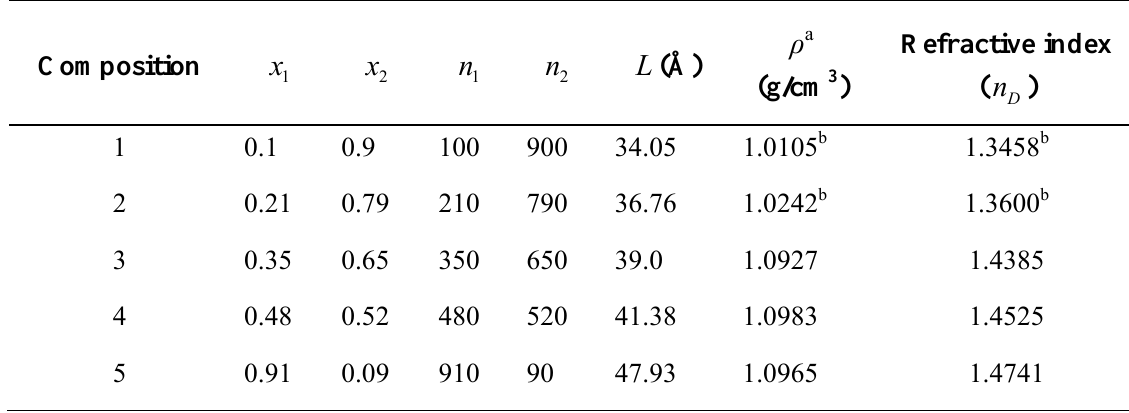
Table 2. Compositions of the DMSO-water mixtures. Solvent 1 is DMSO; solvent 2